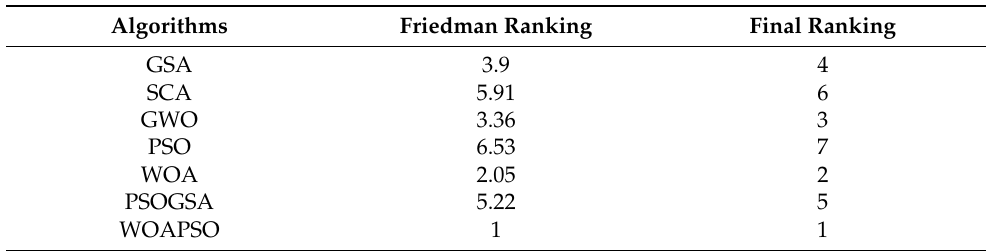
Table 6. Ranking of the proposed WOAPSO and other compared algorithms on three PV models according to the Friedman